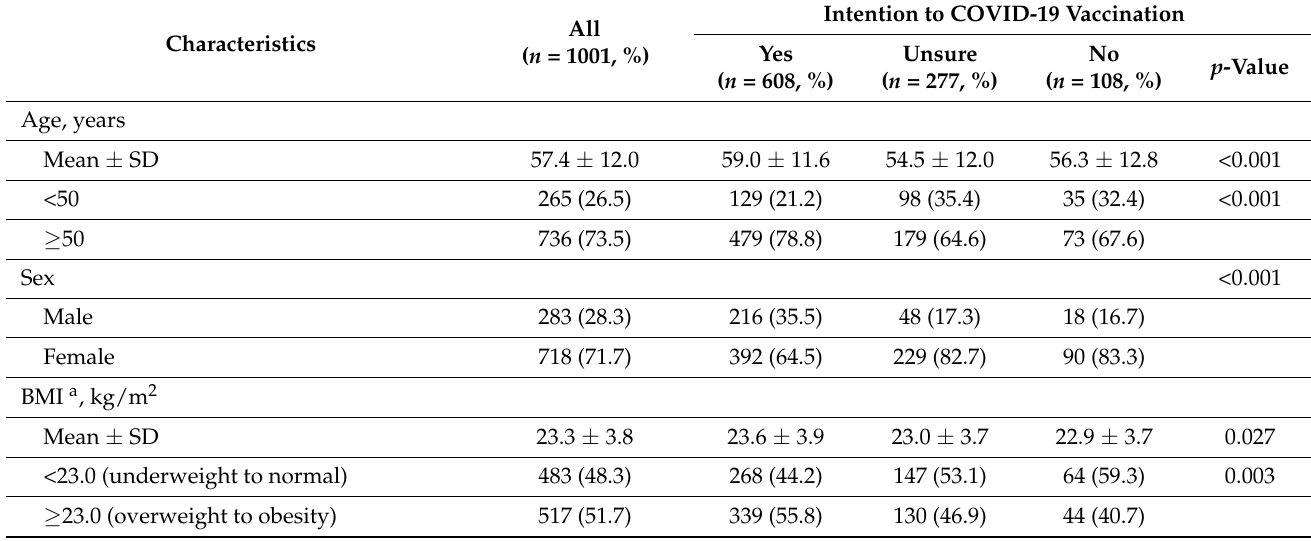
Table 1. Patients’ Table 1. Patients’ characteristics.